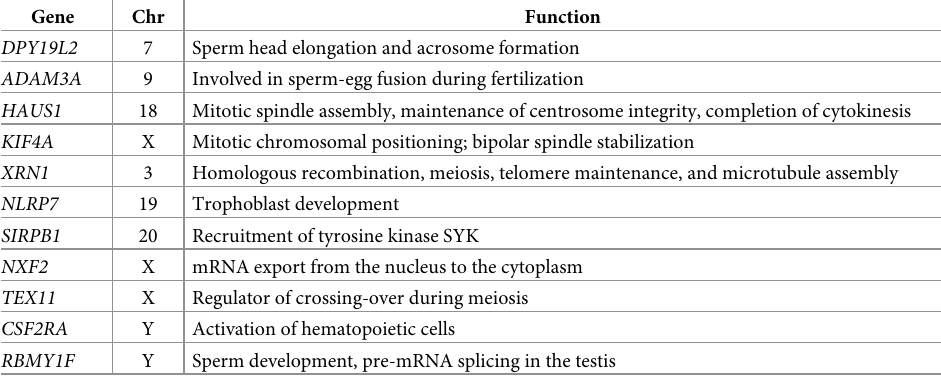
Table 2. List of genes with the largest CNV imbalance according to chromosomes and listed by function. Gene Chr Function